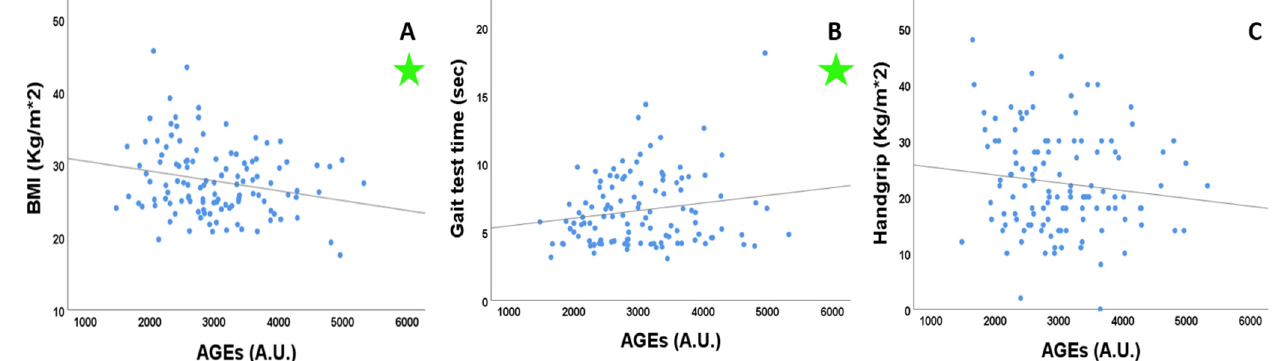
Figure 1. Linear regression analyses of the association of AGEs with BMI, gait speed and hand grip. ( A ) R = − 0.22, p = 0.016; ( B ) R = 0.17, p = 0.049; ( C ) R = − 0.124, p = 0.18. BMI: body mass index; AGEs: advanced glycation end products; A.U.: arbitrary unit. Significant regressions are marked with a green star.